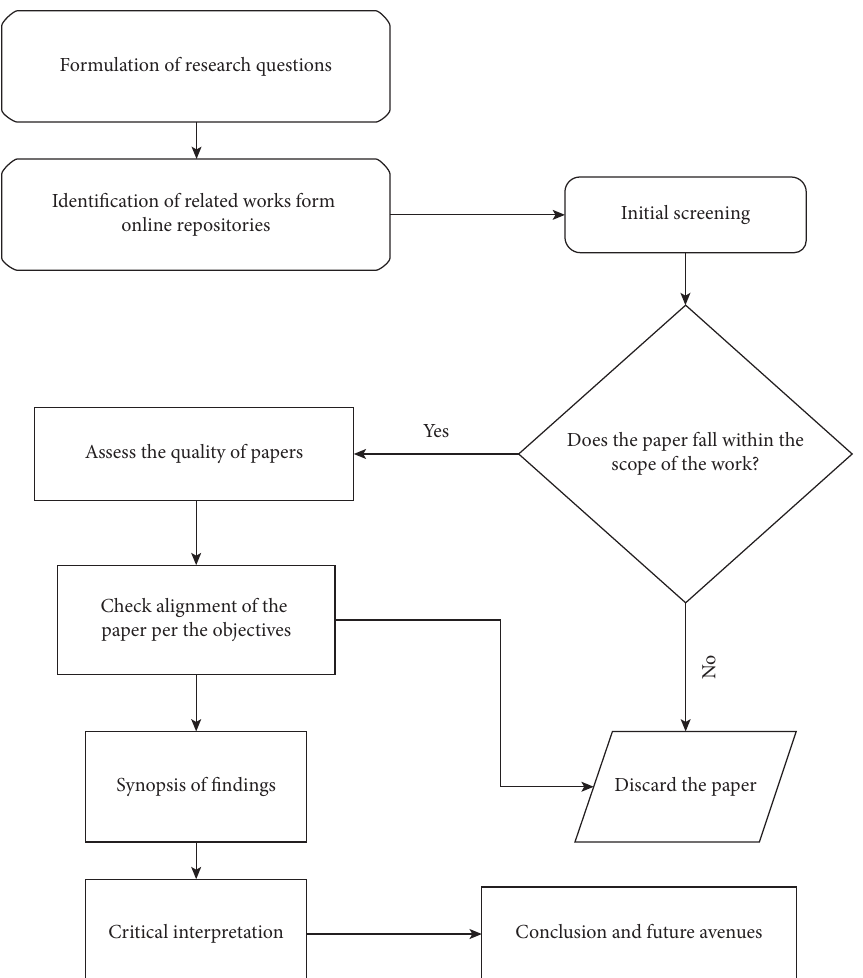
Figure 1: Systematic review approach implemented in the